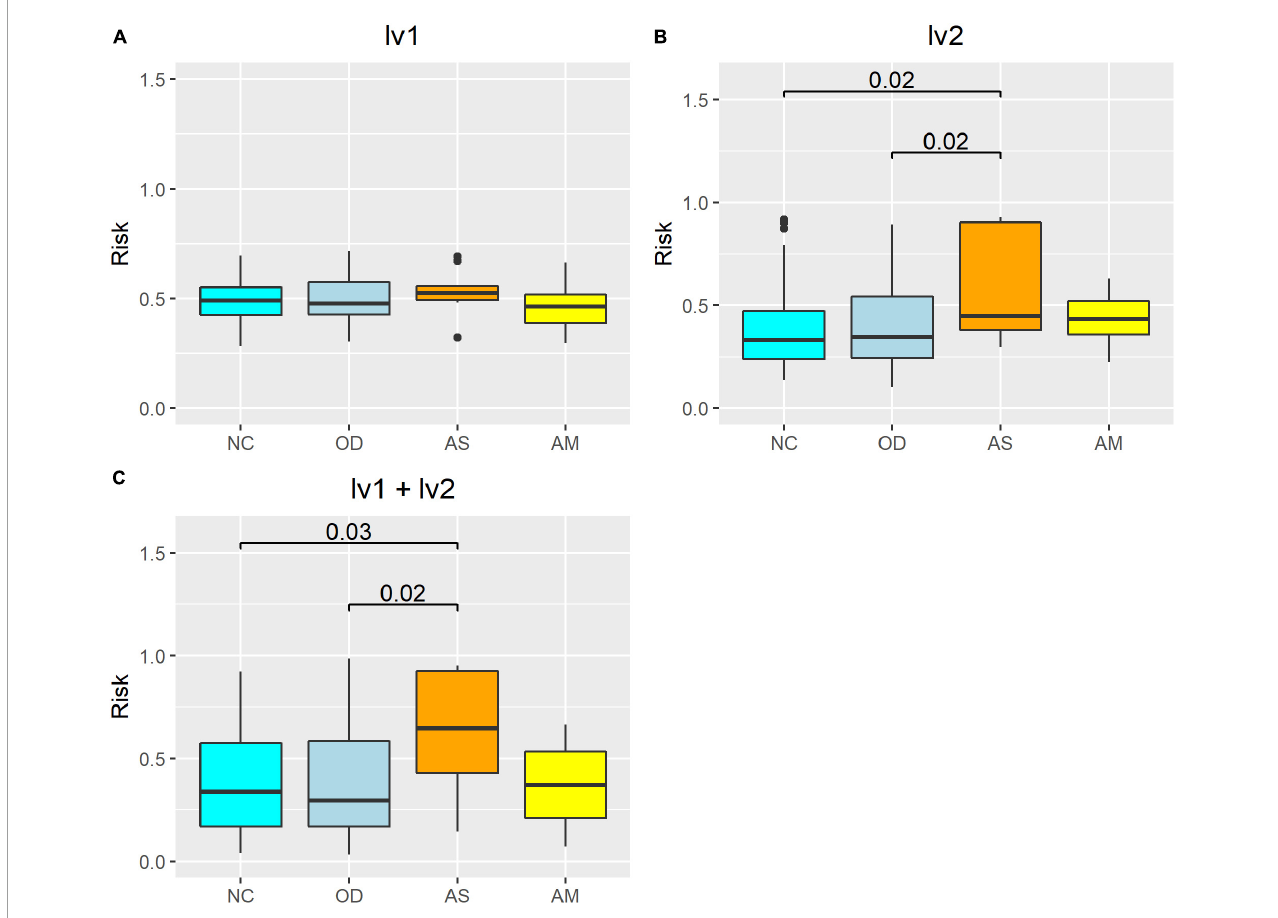
FIGURE7 Atopic dermatitis morbidity probability estimation model using the verification population, the latent variables as explanatory variables, and between-group comparisons. The risk on the vertical axis represents the atopic dermatitis morbidity probability calculated from the logistic regression models. The numerical values on the boxplot represent the p -values in the Wilcoxon–Mann–Whitney rank sum test. Calculation results from the model with latent variables (A) lv1, (B) lv2, and (C) lv1 and lv2 as the explanatory variables. NC: normal controls ( n = 321), AS: patients with atopic dermatitis without other diseases ( n = 45), AM: patients with atopic dermatitis with other diseases ( n = 75), OD: patients with other diseases but without atopic dermatitis ( n = 1,669). The bottom line of the box represents the first quartile value, the middle line represents the median, the top line represents the third quartile, and the points represent